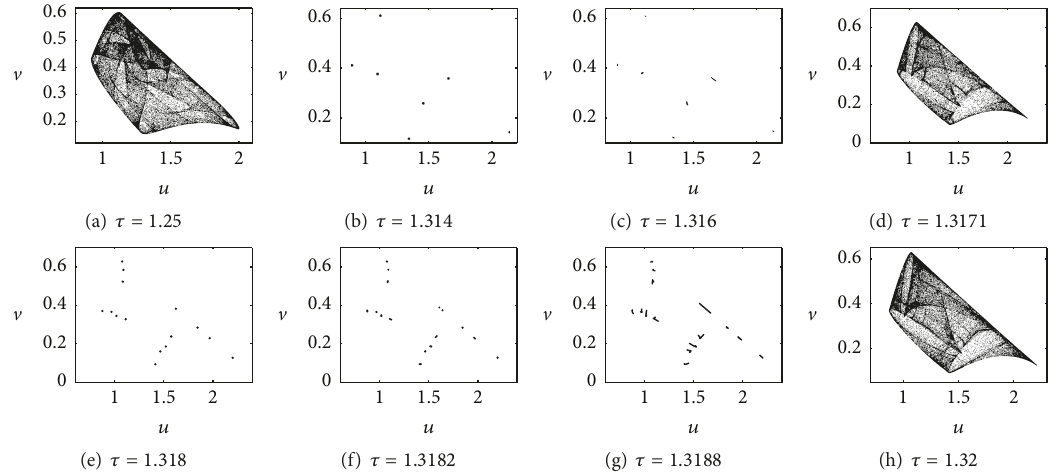
Figure 6: Phase portraits for various values of 𝜏 corresponding to Figure 5(a).